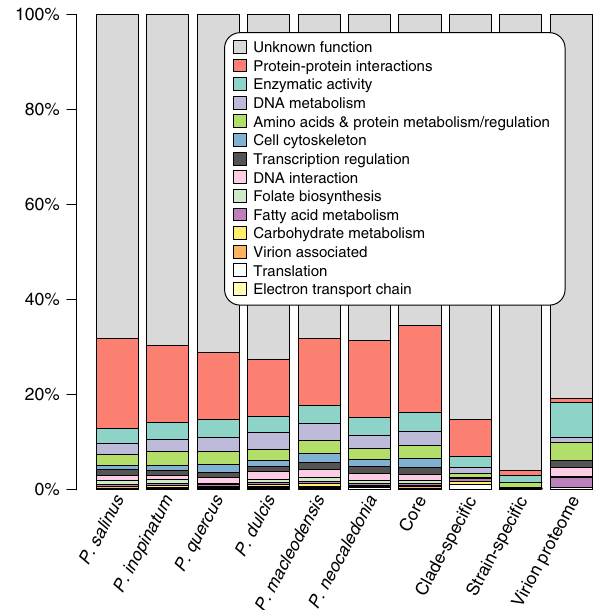
Fig. 5 Functional